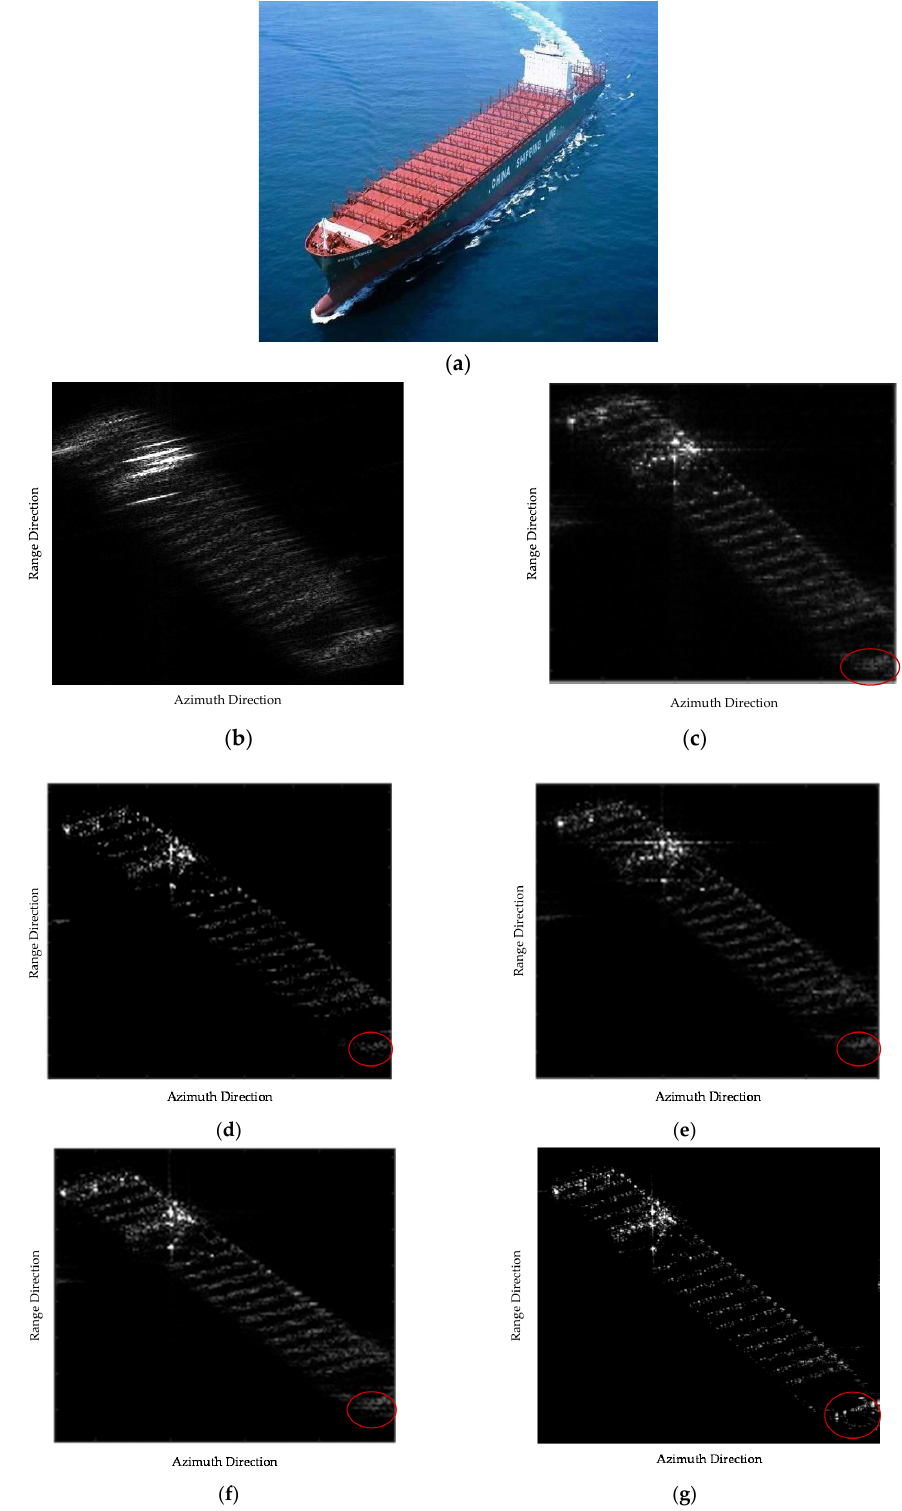
Figure 14. Second case study results: ( a ) A large tanker belonging to the China shipping line; ( b ) Rough imaging result of the tanker obtained by the BP integral; ( c ) Refocusing result of the tanker obtained by the PGA algorithm; ( d ) Refocusing result of the tanker obtained by the CS-ISAR algorithm; ( e ) Refocusing result of the tanker obtained by the DPEA; ( f ) Refocusing result of the tanker obtained by the BPSA; ( g ) Refocusing result of the tanker obtained by the algorithm pre- sented in this paper.